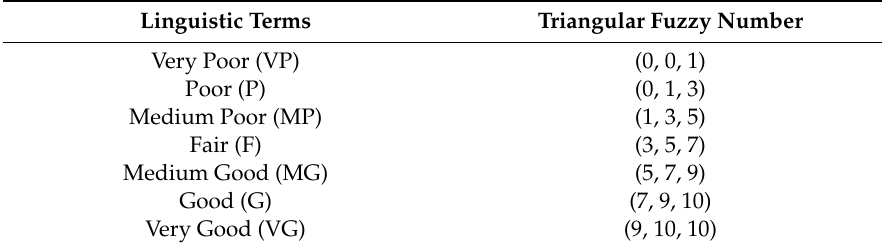
Table 18. Linguistic scale for the